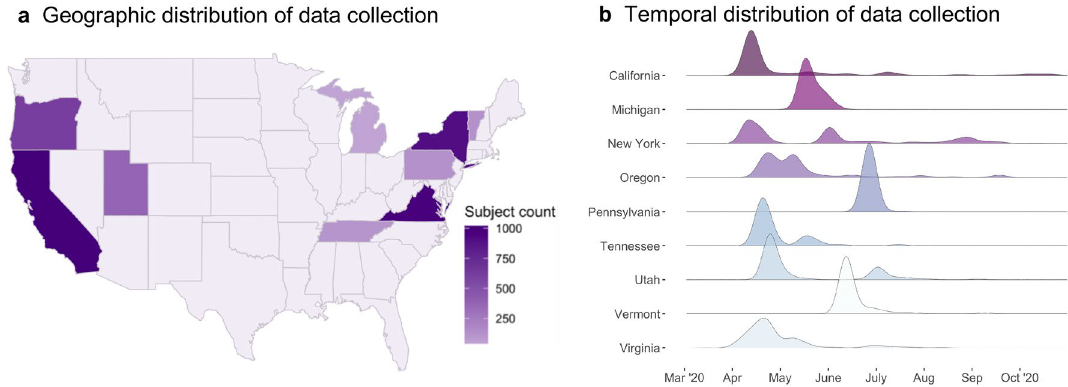
Figure 1. Geographic distribution and study site locations ( a ), and density plots illustrating the temporal distributions of data collection by state ( b